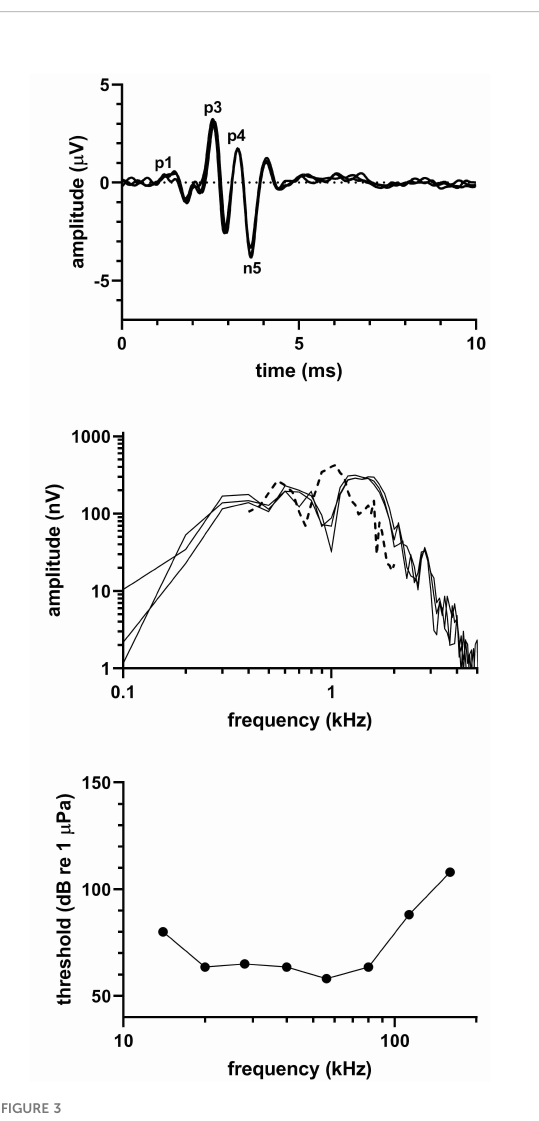
FIGURE 3 (top) Click-evoked ABR, (middle) frequency spectrum of the ABR waveform [solid line] and MRTF [dashed line], (bottom) and audiogram for the melon-headed